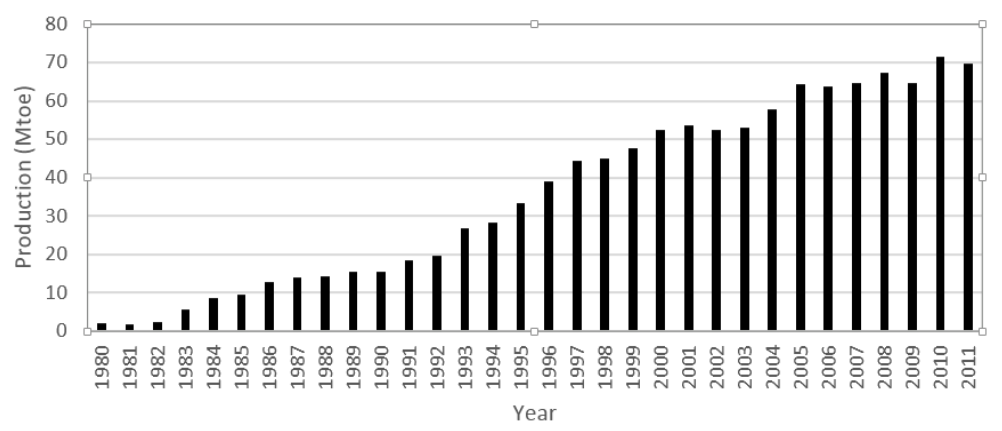
Figure 22. Natural gas production in